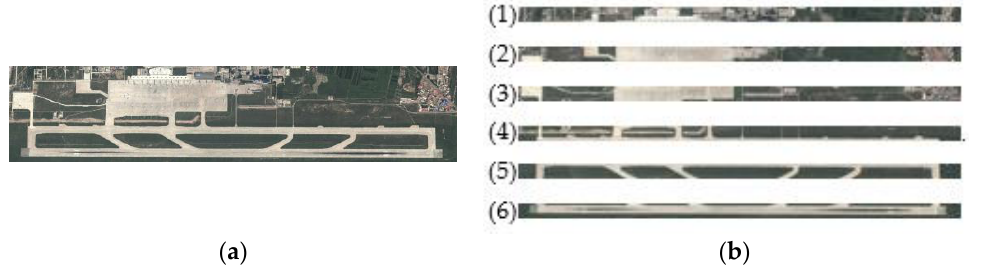
Figure 3. Segmentation result of airports with runways on one side of the terminal. ( a ) Original image; ( b ) segmentation result.